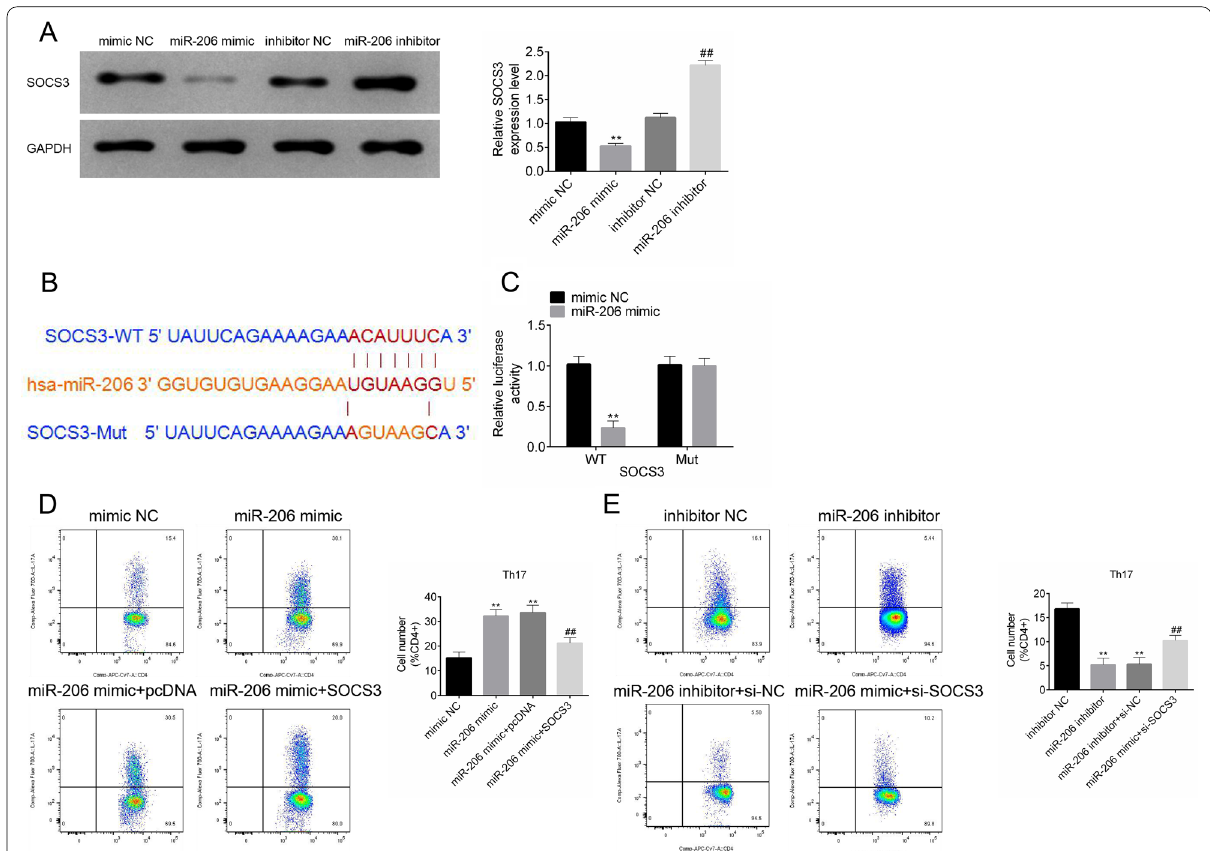
Fig. 2 MiR-206 promoted the generation of Th17 cells via targeting SOCS3. A Expression levels of SOCS3 in CD4 + T cells in response to miR-206 overexpression or knockdown; B Schematic illustration of miR-206 binding sites in SOCS3; C Luciferase assays of the indicated cells transfected with pmirGLO-SOCS3-WT/MUT reporters and miR-206 mimic/mimic NC; D , E The percentage of Th17 cells in CD4 + T cells in response to co-overexpression or co-knockdown of miR-206 and SOCS3. All experiments were repeated three times. Data are expressed as mean ** P < 0.01; ## P <